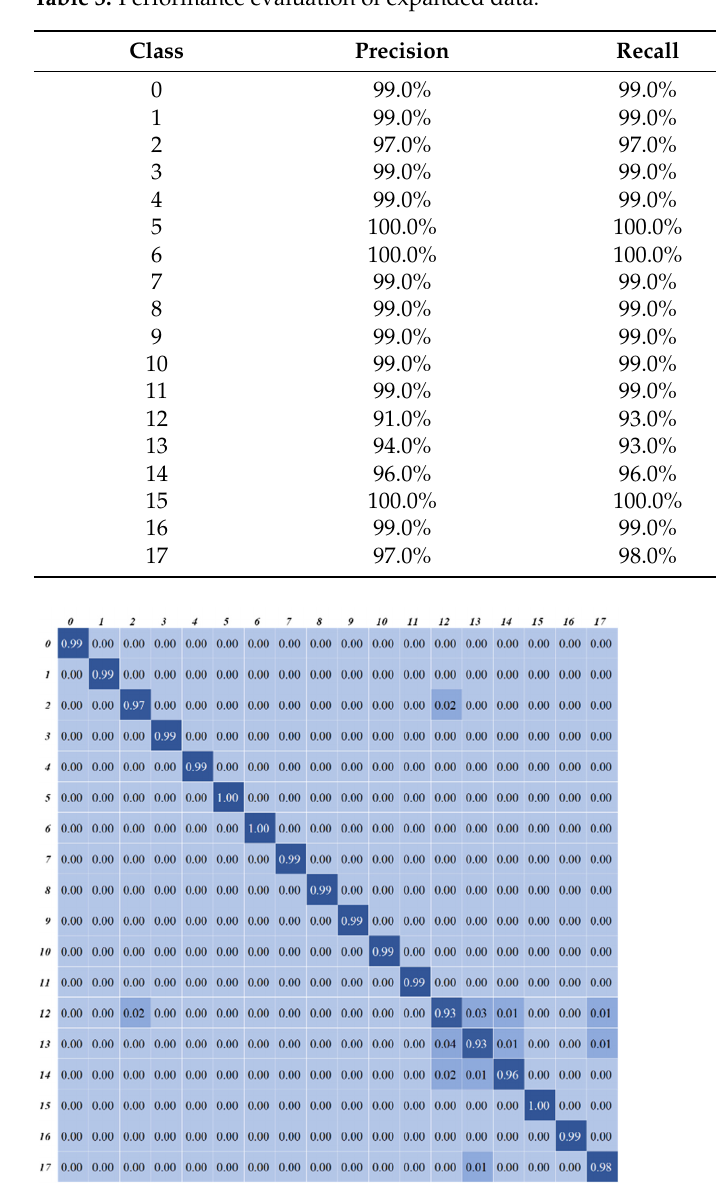
Figure 14. Confusion matrix of validation data (%).